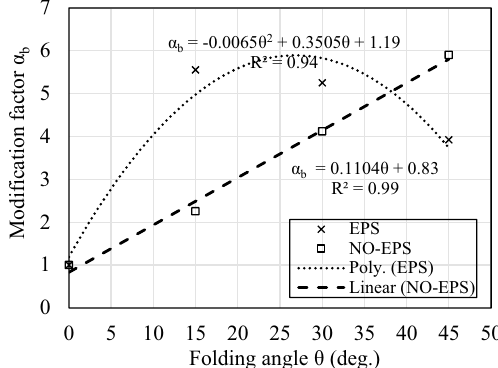
Fig. 17 Bearing capacity global modification